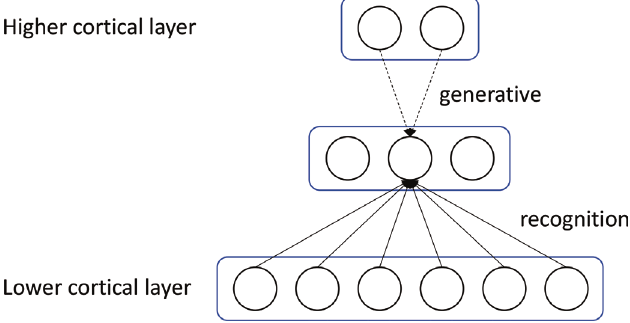
Figure 1: Each hidden neuron of the network receives information from higher and lower cortical layers (here only indicated by the central neuron). The model running from top to bottom is a generative network that produces images, whereas the model from bottom to top is the recognition